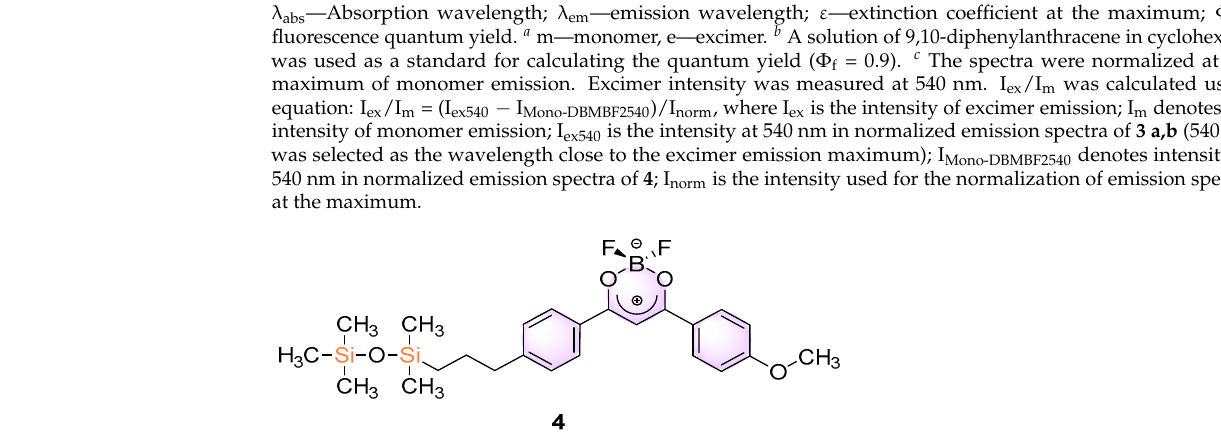
Figure 21. Model compound 4 .